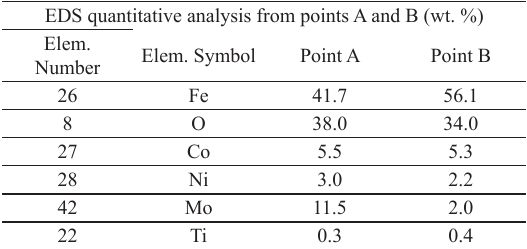
Table 7. Summary of the chemical composition determined by EDS measurements taken at the different positions indicated in Figure 10c. EDS quantitative analysis from points A and B (wt.